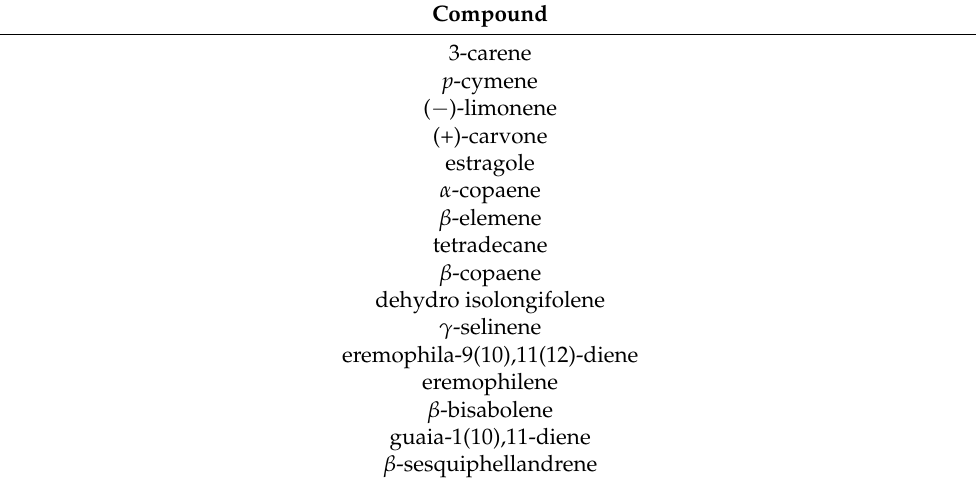
Table 4. VIP analysis: compounds presenting a VIP index